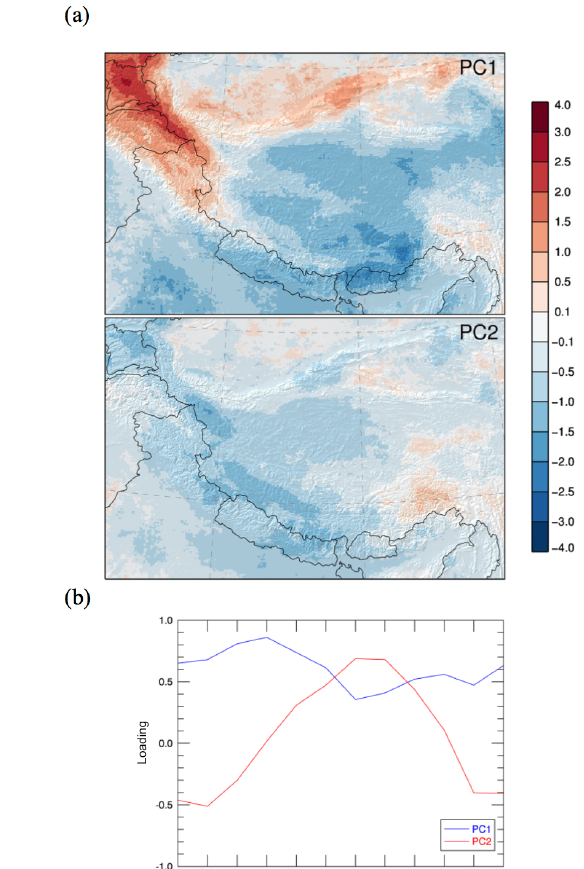
Figure 8. Scores of first two principal components PC1 and PC2 for the correlation between horizontal wind speed at 300hPa (WS300) and precipitation (a) (positive values are denoted in red, while neg- ative values are denoted in blue) and the monthly loadings (b) for both PCs.